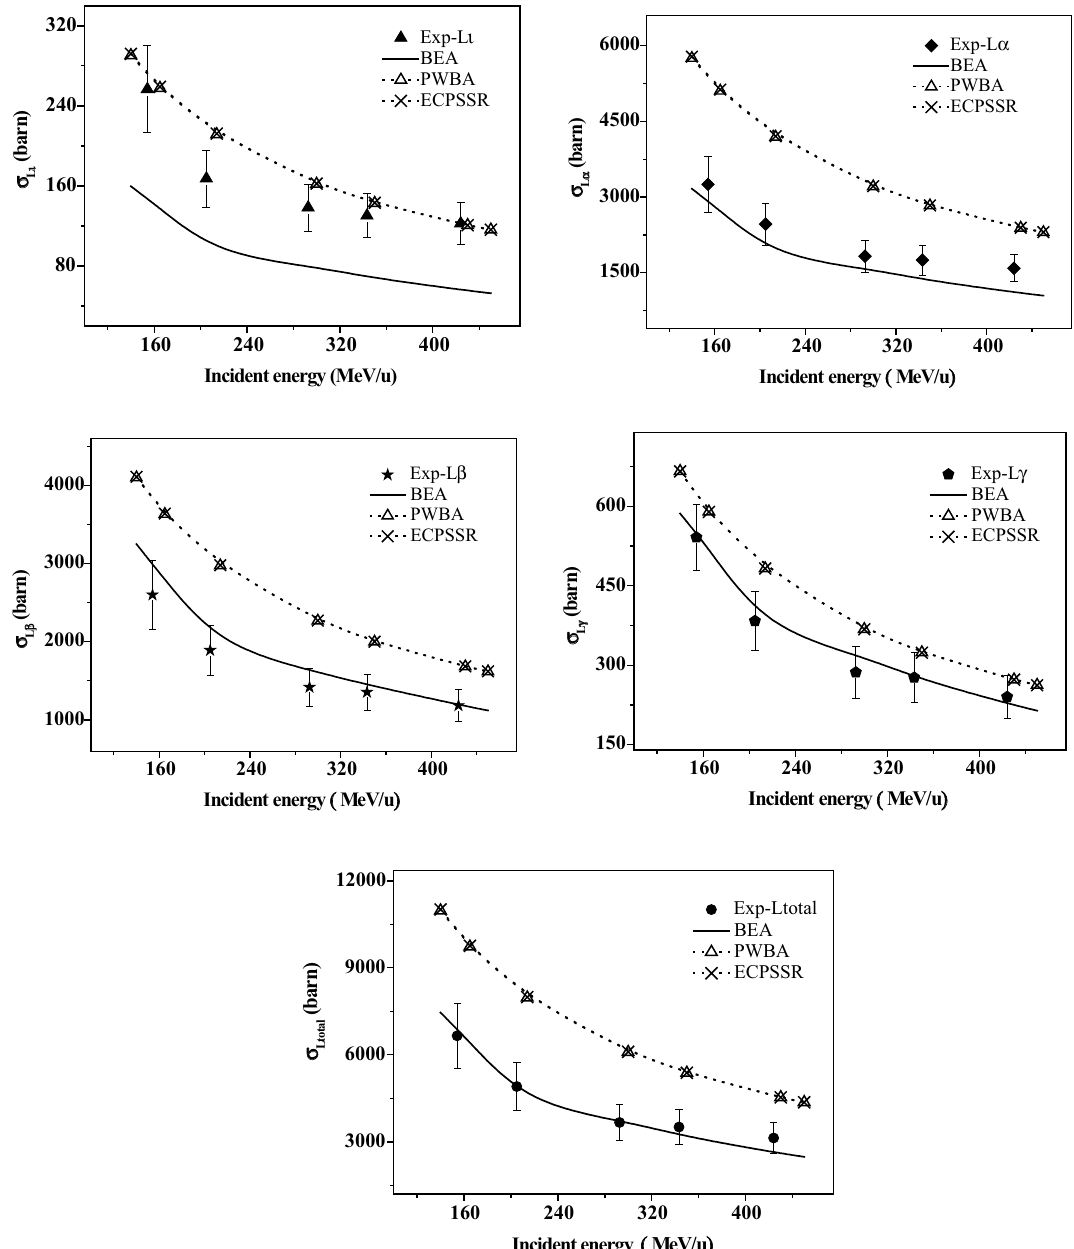
Figure 5. L x-ray production cross section of Au produced by high energy C 6+ ions, and compared with various theoretical